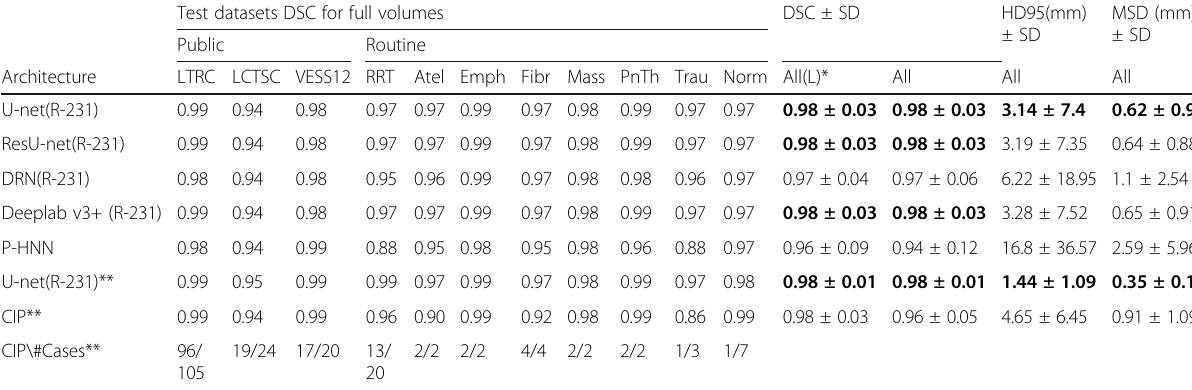
A comparison to the segmentation algorithm of the chest imaging platform (CIP) and the trained P-HNN model is given. The results are expressed in mean and mean ± standard deviation for the Dice similarity coefficient (DSC), Robust Hausdorff distance (HD95), and mean surface distance (MSD) *The LCTSC ground truth masks do not include high-density diseases, and the high number of LTRC test cases dominates the averaged results. Thus, “ All(L) ” ( n = 167) is the mean over all cases that included LCTSC and LTRC, while “ All ” ( n = 62) does not include the LCTSC and LTRC cases **For these rows, only cases on which the CIP algorithm did not fail, and where the DSC was larger than 0 were considered (#Cases). For abbreviations, see Tables 1 and